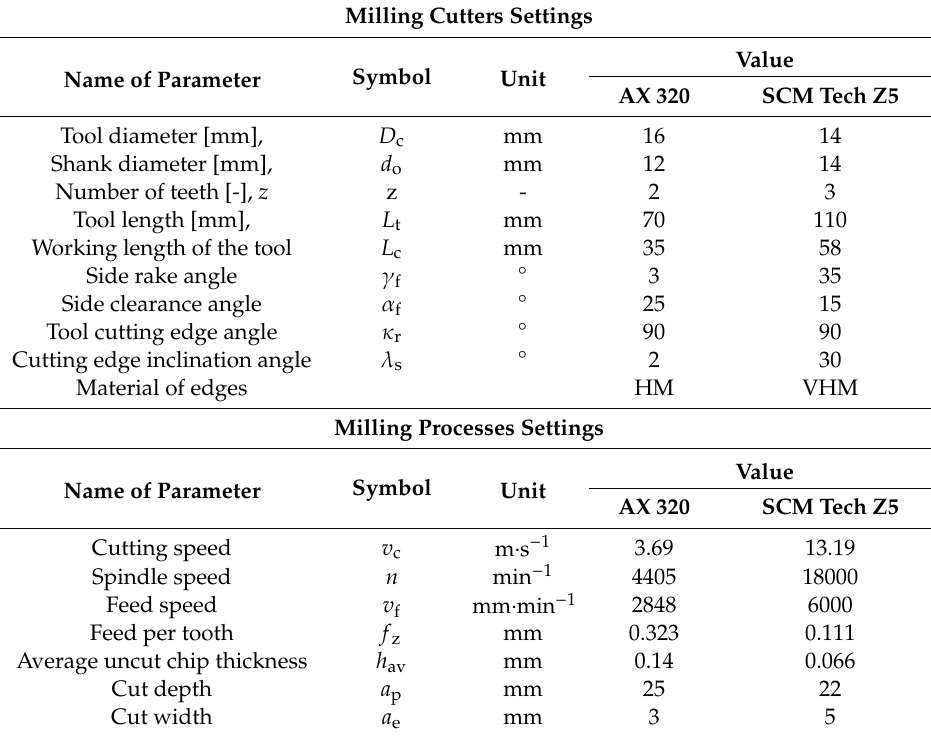
Figure 4. Machine tool AX320 Pinnacle with equipment for machining tests.